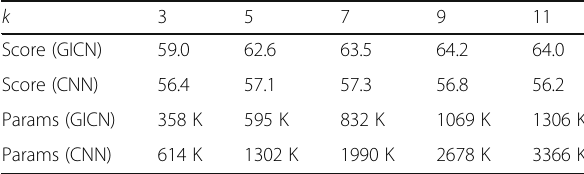
Table 3 GICN and CNN experimental comparison, params means model training